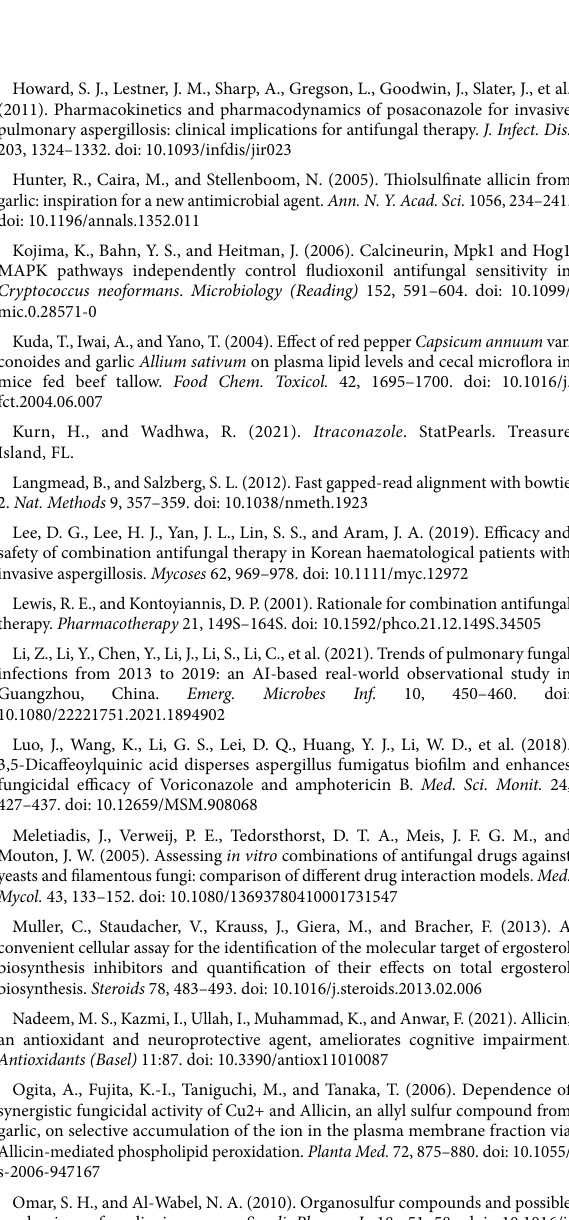
SUPPLEMENTARY FIGURE S1 Results of the allicin content determinations. AX is the peak area of the main peak of the test solution, and AR is the peak area of the main peak of the alanine control